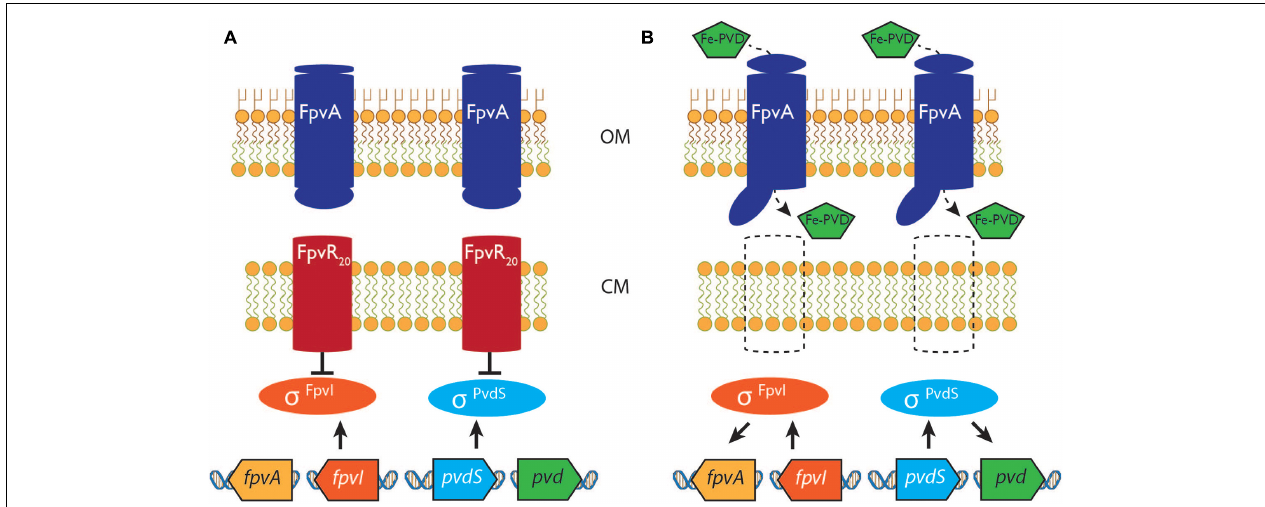
FIGURE 1 | The pyoverdine signaling pathway. (A) In the absence of ferripyoverdine the activities of sigma factors σ FpvI and σ PvdS are inhibited by the antisigma protein FpvR 20 . (B) Import of ferripyoverdine (Fe-PVD) causes a molecular rearrangement of the FpvA receptor protein, triggering a proteolytic cascade that degrades FpvR 20 . σ FpvI and σ PvdS then become active, stimulating expression of the fpvA gene and of pyoverdine (pvd) synthesis genes, respectively. See text and (Llamas et al., 2014) for more detailed information. OM, outer membrane; CM, cytoplasmic